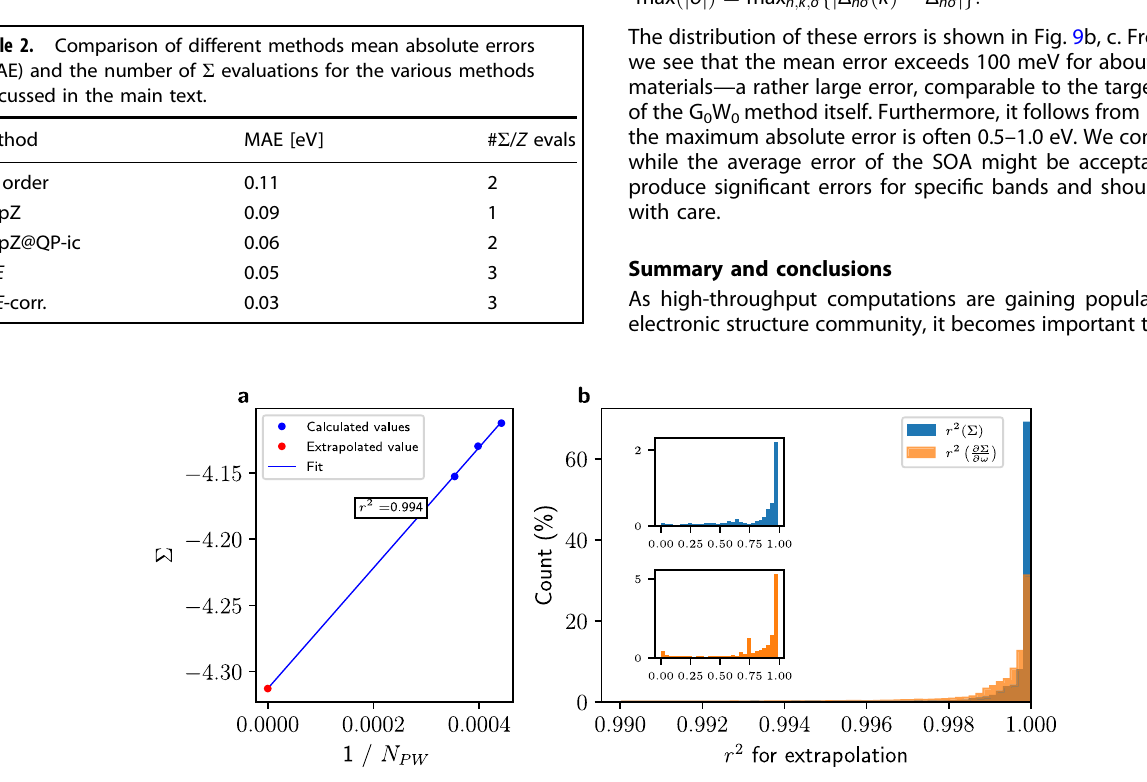
Fig. 8 Plane-wave extrapolation. a Example of the plane-wave extrapolation procedure for the G 0 W 0 self-energy and its derivative. The quantity of interest, e.g., the self-energy, is calculated for three different cutoff energies, here 170, 185, and 200 eV, and the assumed linear dependence on 1/ N PW ( N PW is the number of plane waves) is extrapolated to the in fi nite basis set limit. The coef fi cient of determination for the fi t, r 2 , is shown in the box. b Histogram of the coef fi cient of determination, r 2 , for the 61,716 plane-wave extrapolations of self-energies (blue) and the derivatives of the self-energy (orange). The plot shows the distribution for the coef fi cient of determination r 2 ≥ 0.99, while the insets show values outside this range. A total of 5.5% and 14.1% of the values are <0.99 for the self-energy and its derivative,